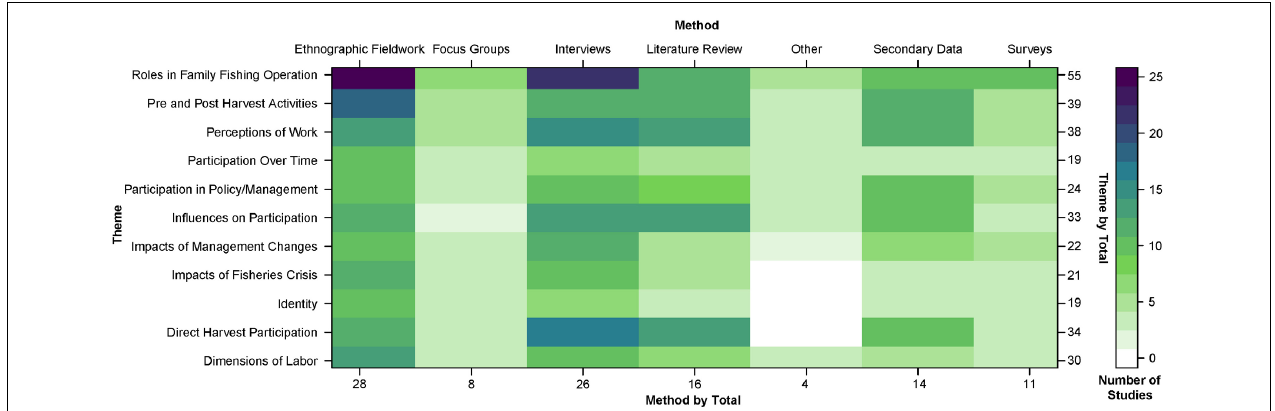
FIGURE 2 | Main themes explored in the literature on women’s fisheries participation by method employed to examine